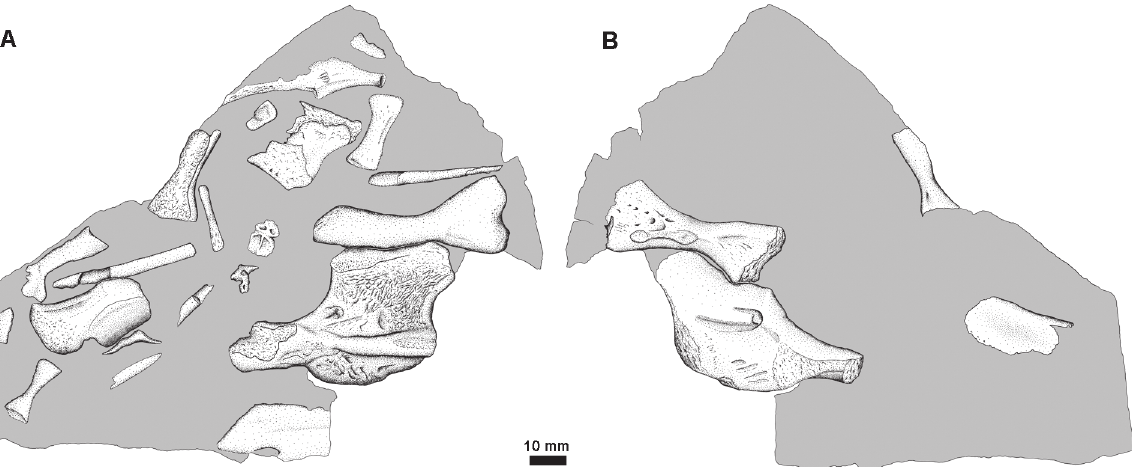
Fig 17. Associated material from Blue Beach. NSM005GF045.034, the ‘ Sherm Block ’ (for collector Sherman Williams) of associated front and hind limb